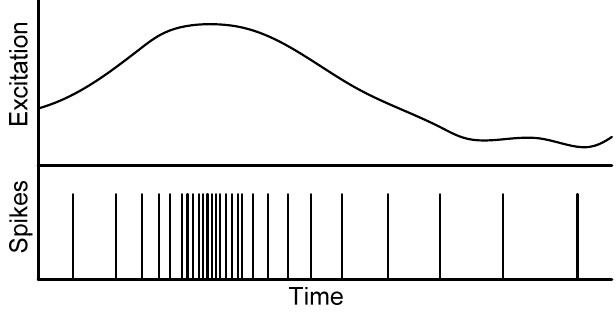
Figure 1. Spikes codification for a variable excitation